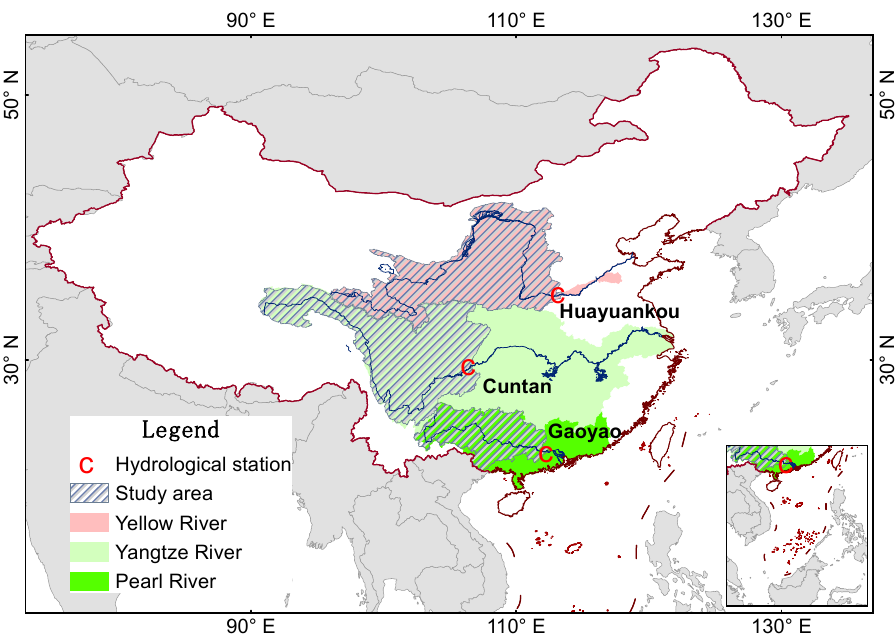
Figure 1. Locations of the study areas and hydrological stations.